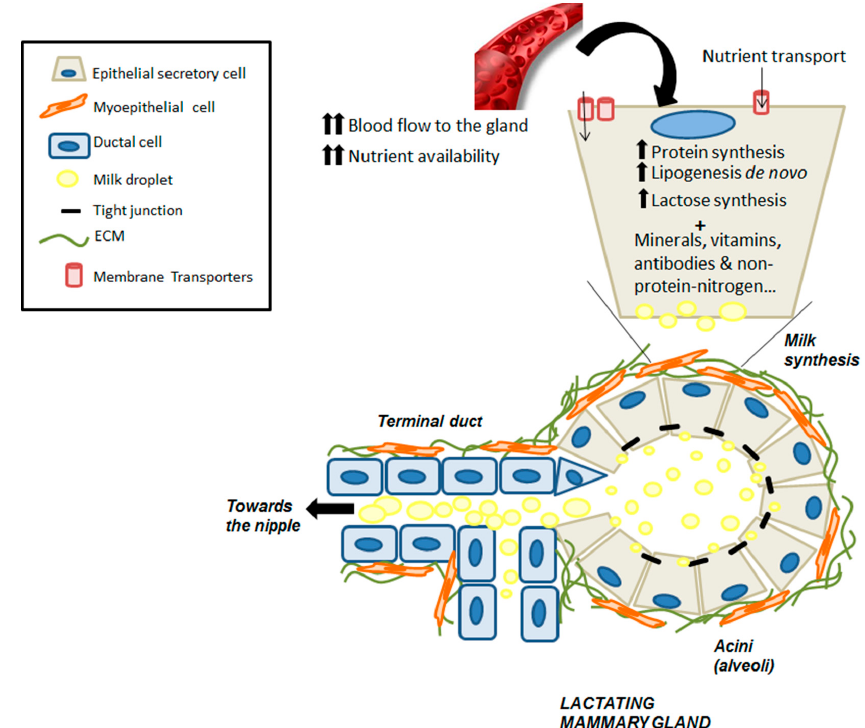
Figure 3. Metabolic events that lead to milk synthesis in alveolar cells from lactating mammary gland. During lactation, increased blood flow and intertissue redistribution of nutrients toward the mammary gland, together with increased membrane transporters, ensure bioavailability of precursors for milk synthesis within the epithelial cells. Both lipid and carbohydrate anabolism are increased, as is protein synthesis. Within the apex of the alveoli, milk-lipid droplets are formed and released toward the lumen with other milk components such as vitamins, minerals, and salts [81–85]. Vitamin A sources for the mammary gland comprise REs and carotenoids packed in the chylomicrons synthesized from dietary intake, and serum retinol (RBP4–retinol), which does not vary over a wide range of vitamin A ingestion and will be esterified within the mammary gland. During lactation, hyperphagia allows for higher vitamin A and carotenoid intake, which is associated with increased redistribution to the mammary tissue and thus to the secreted milk. REs associated with chylomicrons from the diet travel through the lymph and plasma, reaching extrahepatic tissues before getting to the liver. During breastfeeding, a great proportion of this vitamin A from the diet is redirected, preferably to lactating mammary tissue, as the activity of LPL in the mammary gland is a determinant for this highest uptake by the gland [53–55]. Indeed, the higher activity of LPL in thr mammary gland and the depressed activity in other tissues, such as adipose tissue, triggers the transfer of fatty acids, partial triglycerides, some unesterified cholesterol, and fat-soluble vitamins to the parenchymal cells of the gland during lactation (Figure 1). Once inside the mammary secretory epithelial cells, retinol is found to be bound to CRBPs, which will facilitate metabolism or excretion of this compound. In fact, it has been reported that CRBP-I and CRBP-III are both expressed in the mammary gland at different developmental stages. CRBP-III-null mice showed reduced RE levels in milk, suggesting that this isoform plays a role in retinol metabolism within lactating mammary tissue